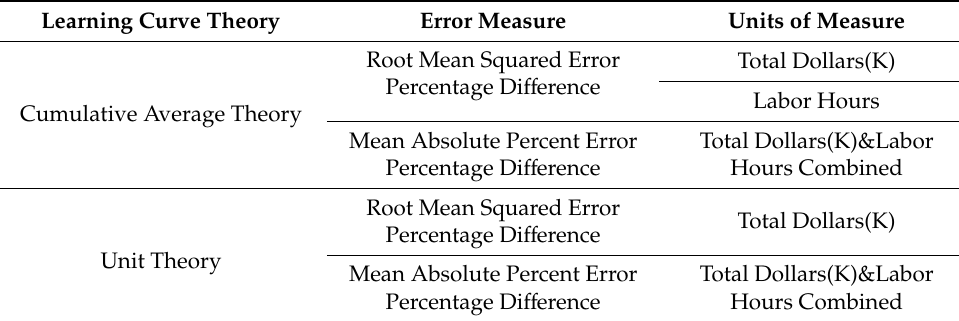
Table 1. Paired Di ff erence Hypothesis Tests